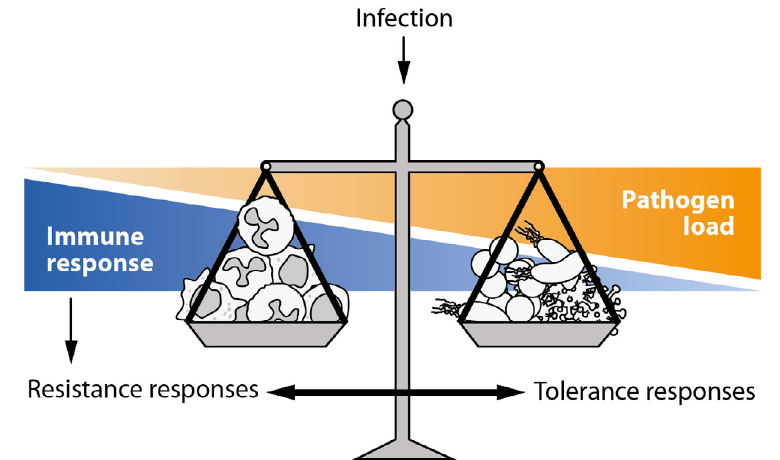
Figure 2. Two phenotypes of immune responses to infection